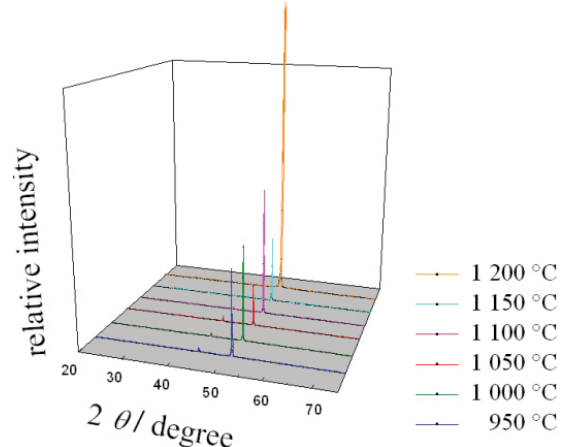
Figure 6. XRD diffraction pattern of annealed CuNi44 substrates. The (200) signals are dominating; while especially at lower temperatures the (111) signals are visible.